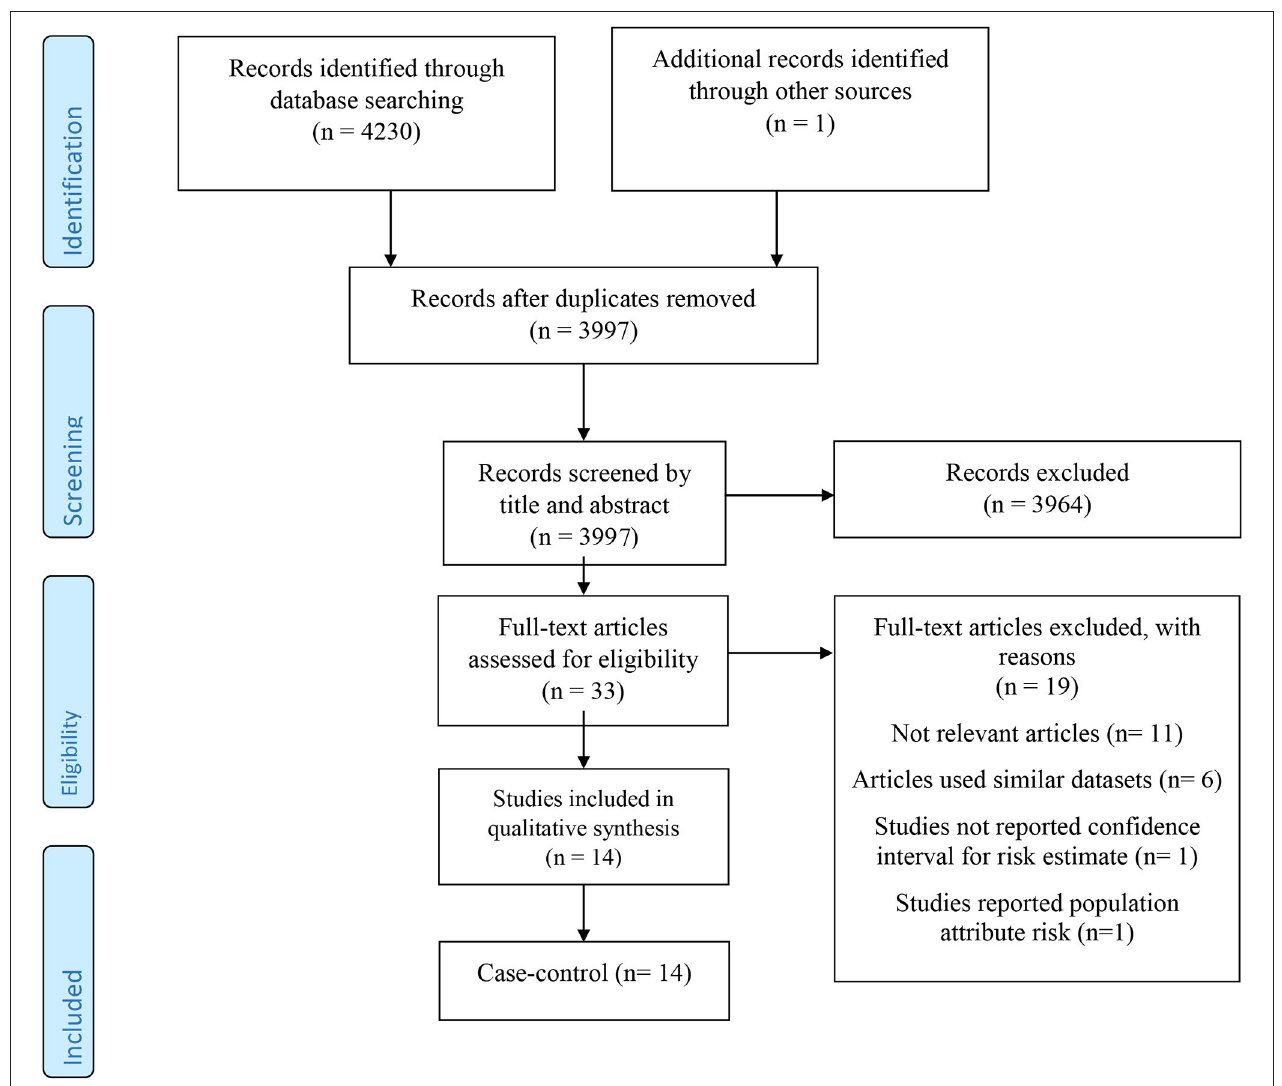
FIGURE 1 | The flow diagram of study